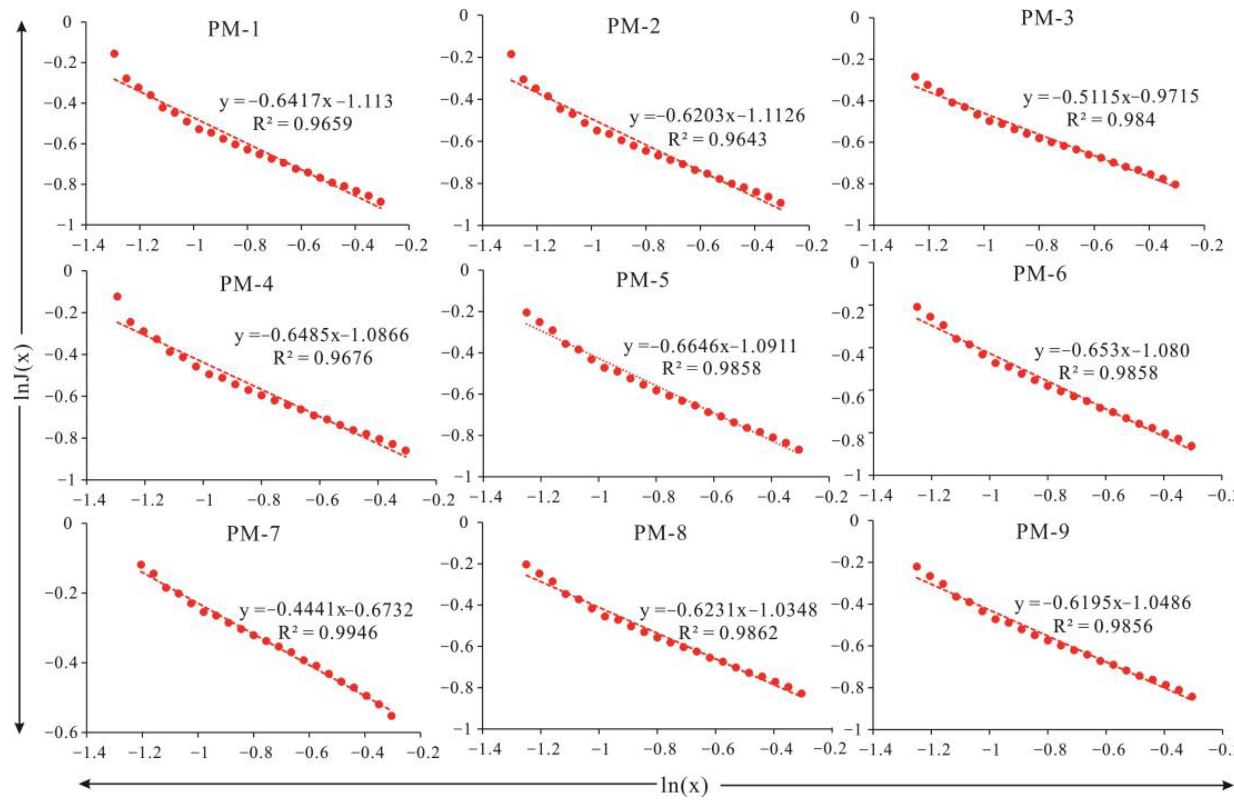
Figure 7. Fractal dimension fitting of the CO 2 adsorption data of coal samples. Table 4. Fractal dimension of the CO 2 adsorption data of coal